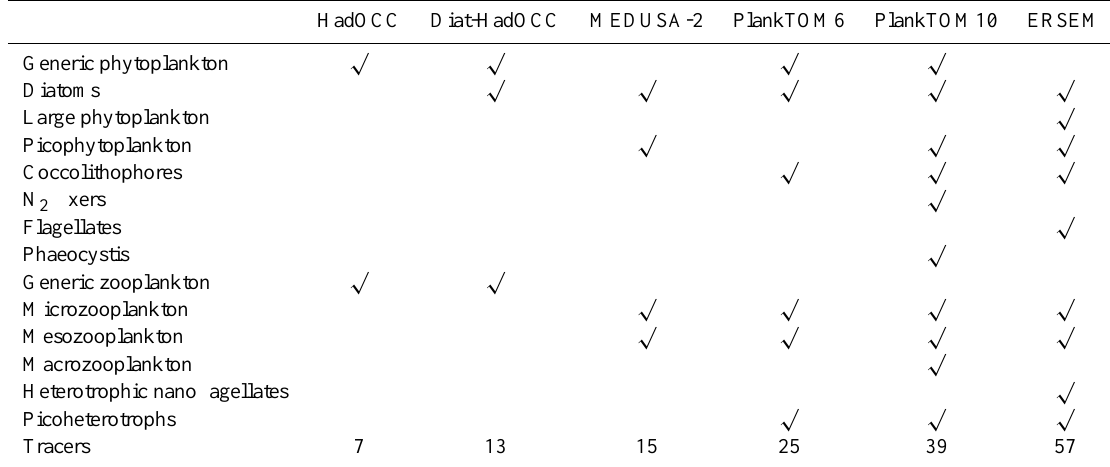
Table 2. Composition of the marine ecosystems represented in each candidate model along with the total number of biogeochemical tracers (including those detailed in Table 1). HadOCC Diat-HadOCC MEDUSA-2 PlankTOM6 PlankTOM10